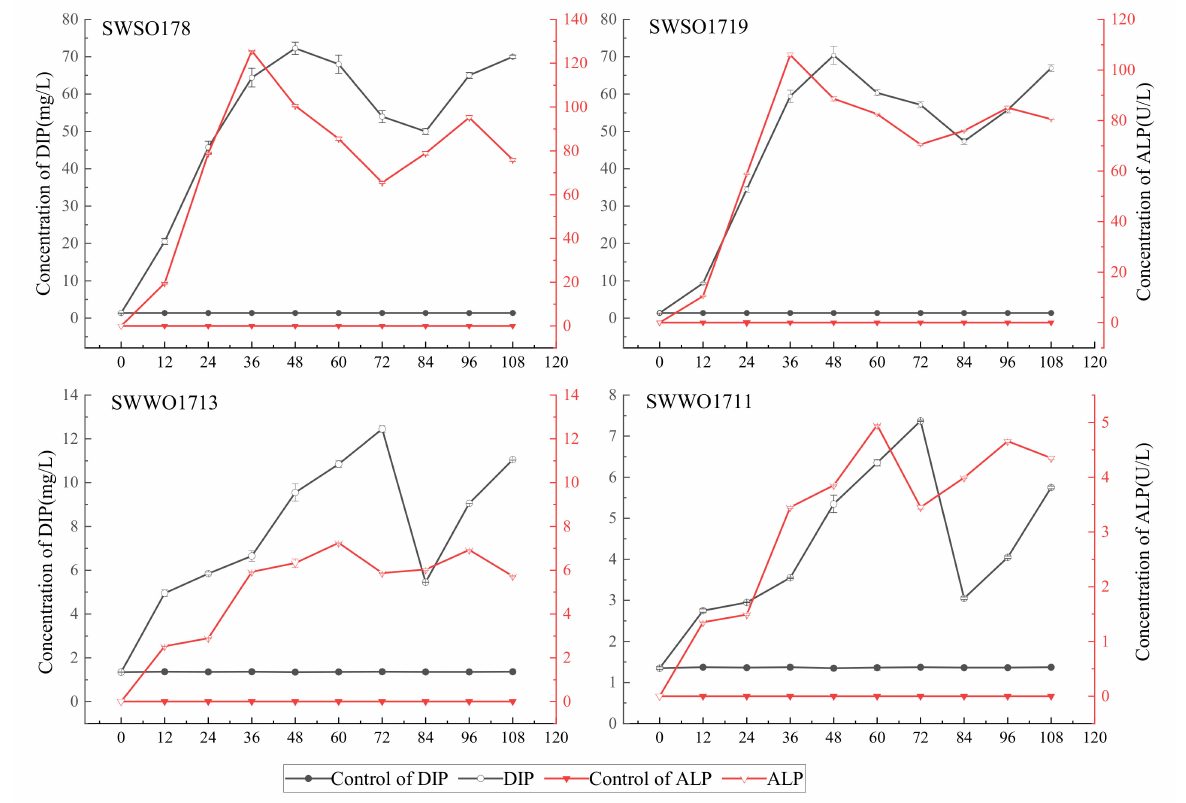
Figure 3. Changes in concentrations of ALP and DIP in SWSO178, SWSO1719, SWWO1713, and SWWO1711 liquid culture. Note: growing broth at 25 ◦ C after 12, 24, 36, 48, 60, 72, 84, 96, and 108 h of growth. Each value is a mean of three independent